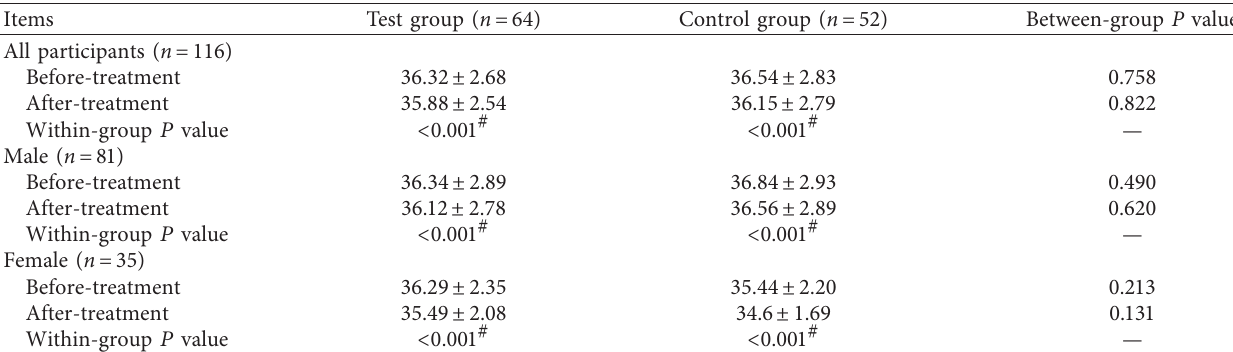
Table 6: Circumference of the injured knee ( N �